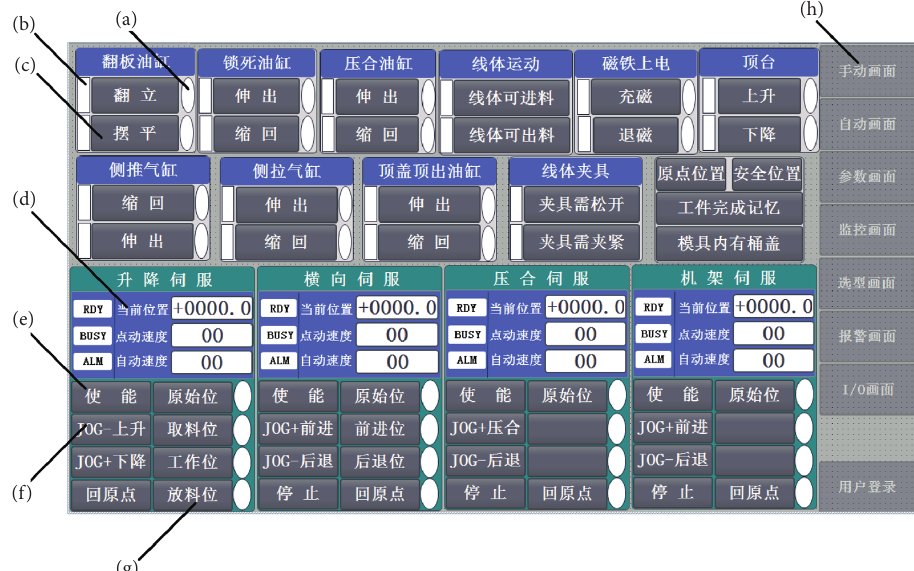
Figure 16: Manual operation interface of water heater tank top press system. (a) Operation feedback indication. (b) In-place instructions. (c) Operation button. (d) Servo motor monitoring. (e) Servo motor power up. (f) Servo motor inching control. (g) Step operation. (h) Navigation bar.